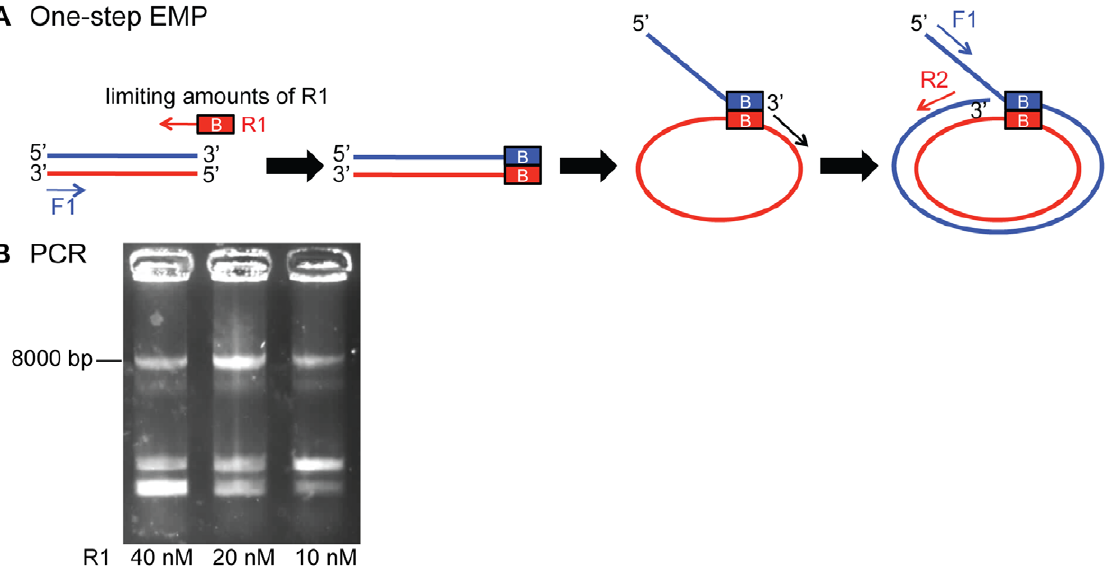
Figure 5. Applications of EMP cloning: One-step EMP. EMP cloning allows for megaprimer production and insertion in a single PCR reaction. (A) In a one-step EMP PCR reaction limiting amounts of the overhang containing primer R1 are used to reach primer depletion in the first cycles.